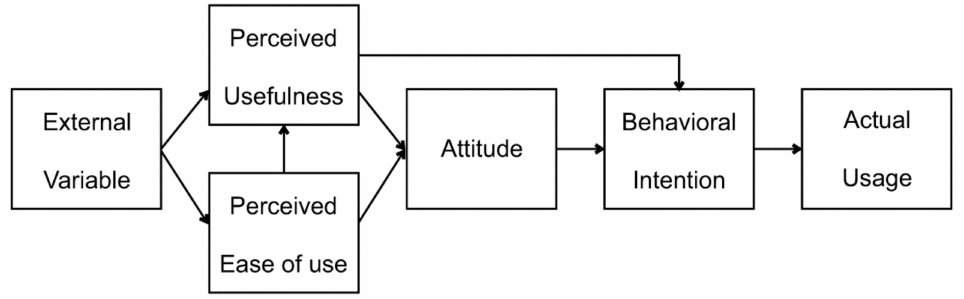
Figure 1. Technology Acceptance Model (TAM) by Davis